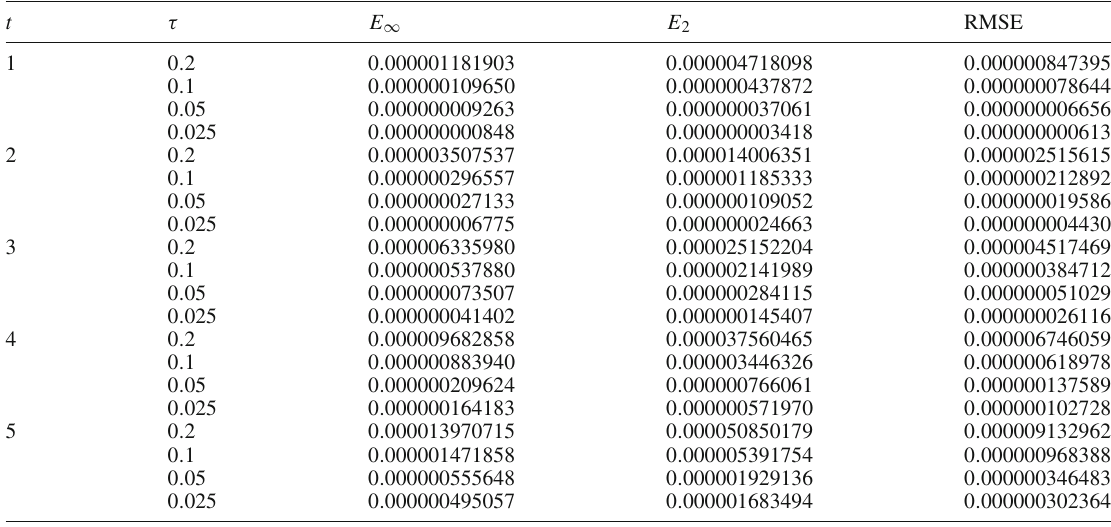
Table 7 The errors for various values of τ with M = 31 MQ-RBFs, c = 1 . 65, α = 0 . 2 and [ a , b ] = [− 2 , 2 ] for Example 2